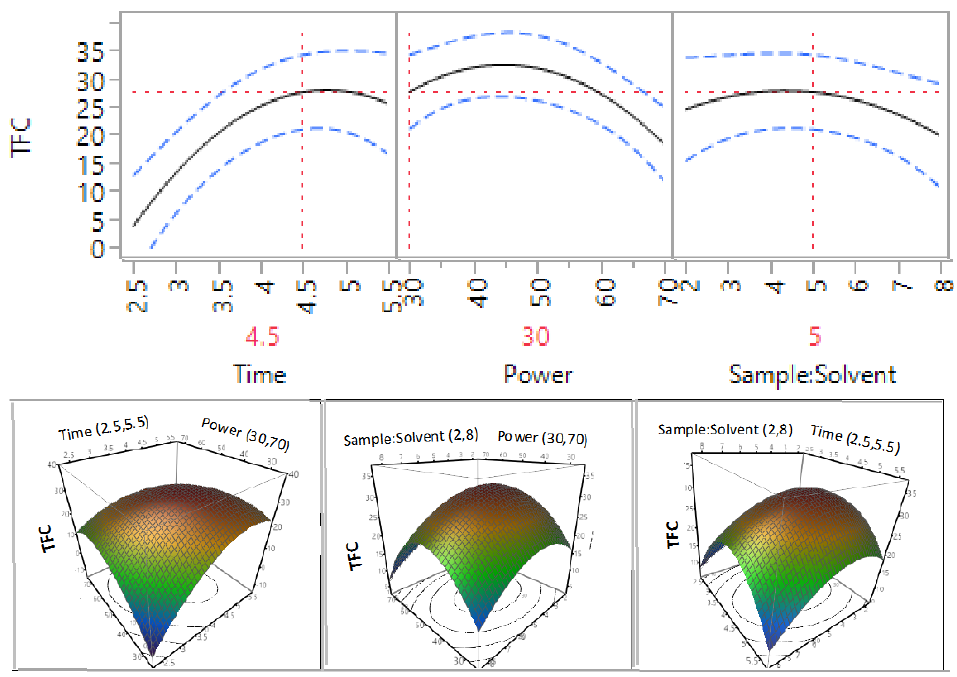
Figure 5. Impact of time (2.5–5.5 min), power (30%–70%, 360–840 W) and sample-to-solvent ratio (2–8 g/100 mL) on flavonoids (mg RE/g).